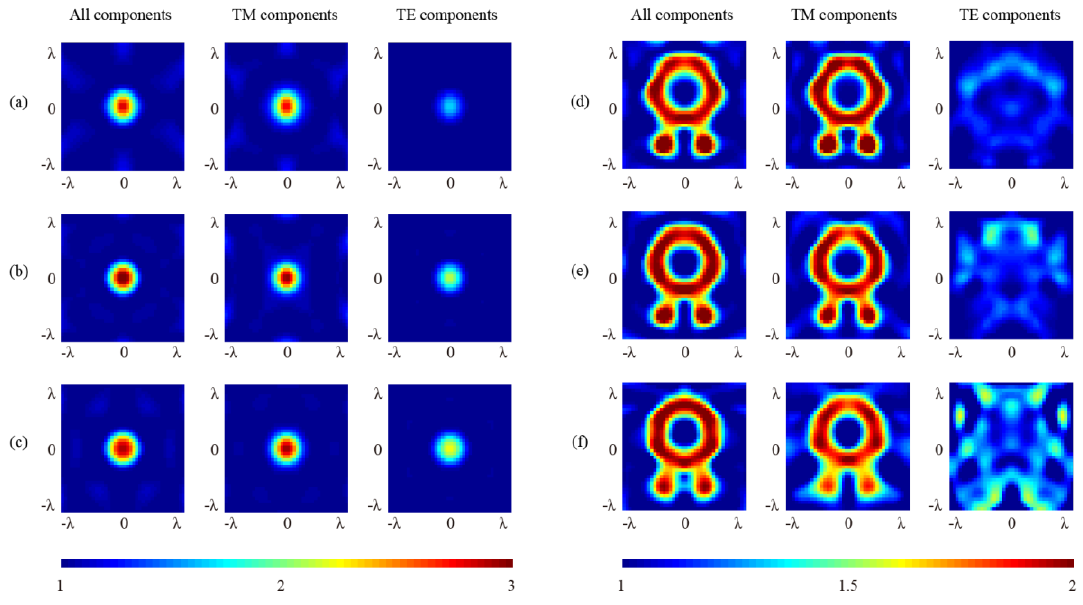
Figure 8. The retrieved cross section profiles of the 2D cylinder using different polarization components of the scattered field. ( a ) 15° angle of incidence; ( b ) 30° angle of incidence; and ( c ) 45° angle of incidence. The retrieved cross-section profiles of the 2D “Austria” profile using different polarization components of the scattered field; ( d ) 15° angle of incidence; ( e ) 30° angle of incidence; and ( f ) 45° angle of incidence. Table 1. Error analysis for different 2D